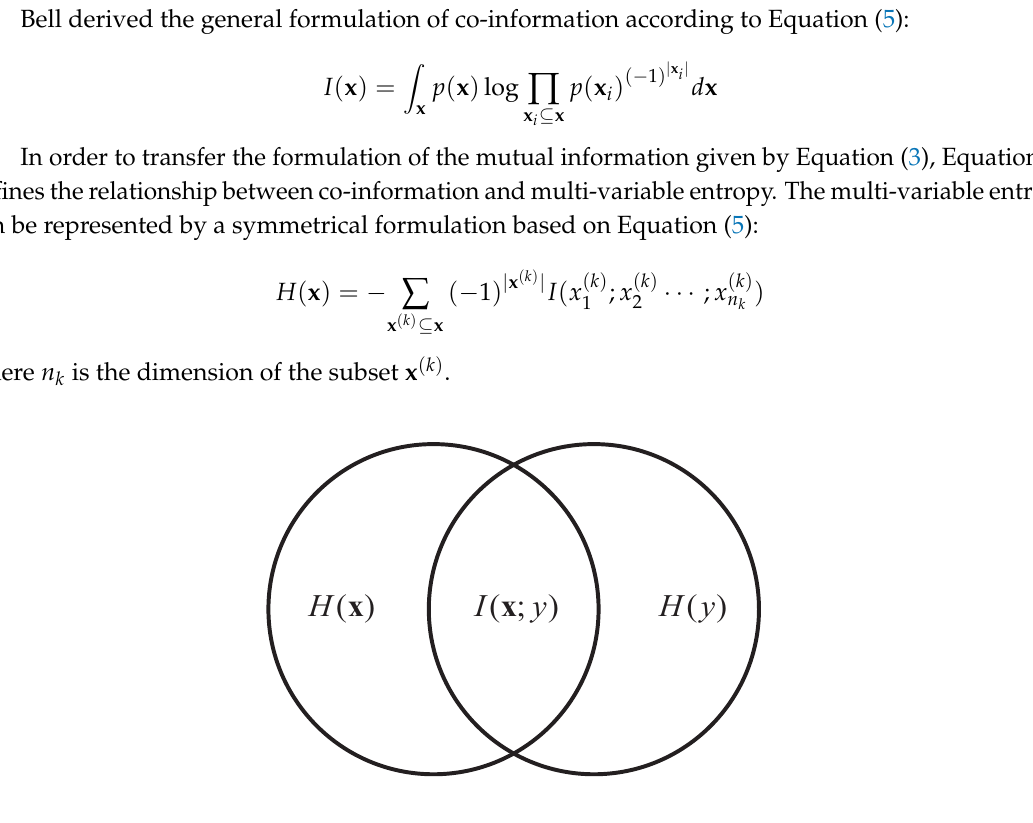
Figure 2. Relation of the input variables and label according to mutual